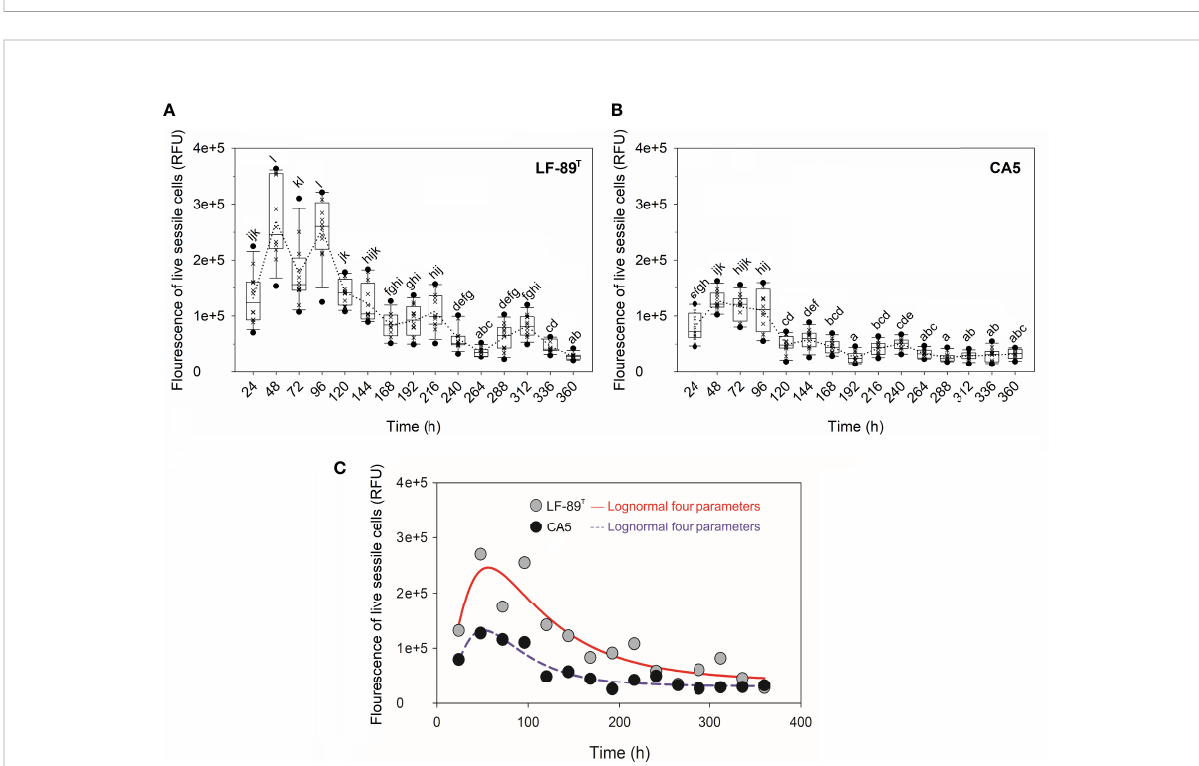
FIGURE 3 Fluorescence signal of live sessile bacteria and bio fi lm growth prediction. Fluorescence signal was measured in relative fl uorescence units (RFU) in bio fi lms formed by P . salmonis (A) LF-89 T and (B) CA5 previously stained with the LIVE/DEAD reagent. Each box plot shows the median of fl uorescence data sets (×), upper/lower quartiles (boxes), value ranges (vertical lines), extreme values (circles), and general patterns (dotted lines). Statistically signi fi cant differences between boxes (Tukey HSD test; P < 0.05) are denoted with different letters. (C) The bio fi lm mode of growth was predicted by fi tting a four-parameter lognormal distribution to fl uorescence data. The proportion of variance explained by this model accounted for ~88% on average. Data are representative of three independent